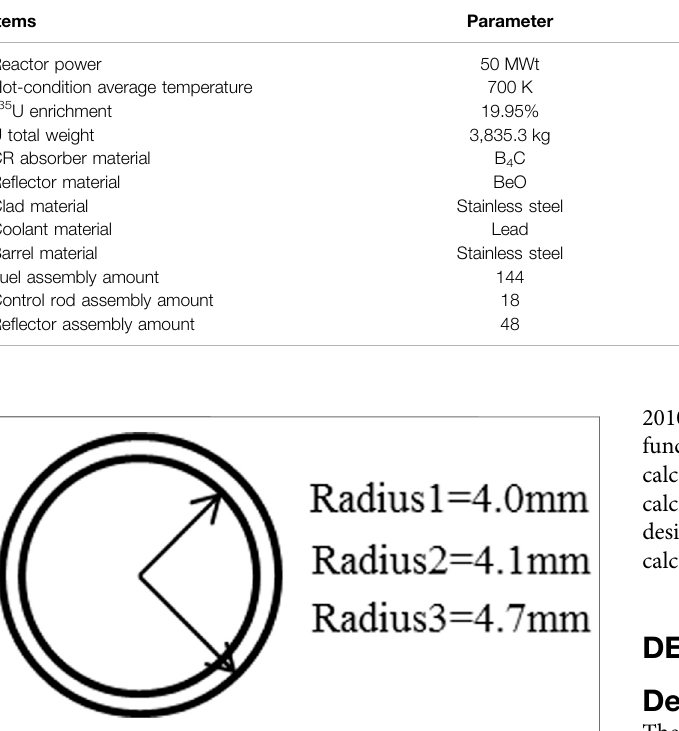
FIGURE 1 | Pin cell geometry of the SLBR-50; (A) fuel assembly, (B) re fl ector assembly, and (C) control rod assembly.